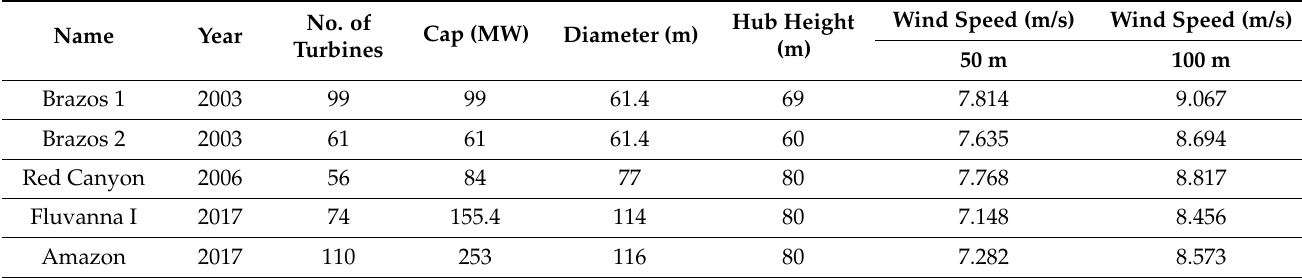
Table 3. Data from the evaluated cluster of five wind farms in north west Texas.